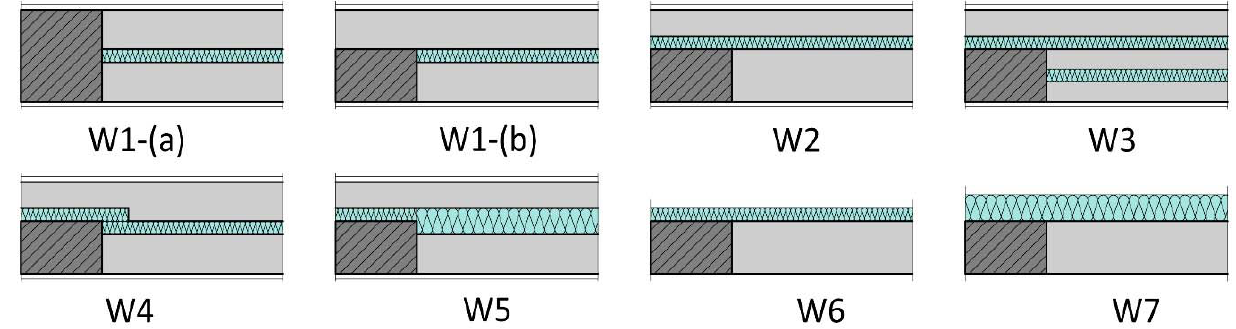
Figure 6. Wall section alternatives investigated; the column and the wall in W1 ‐ (a) represent S1, S2 in Building ‐ 3, and the column in W1 ‐ (b) represents S3.